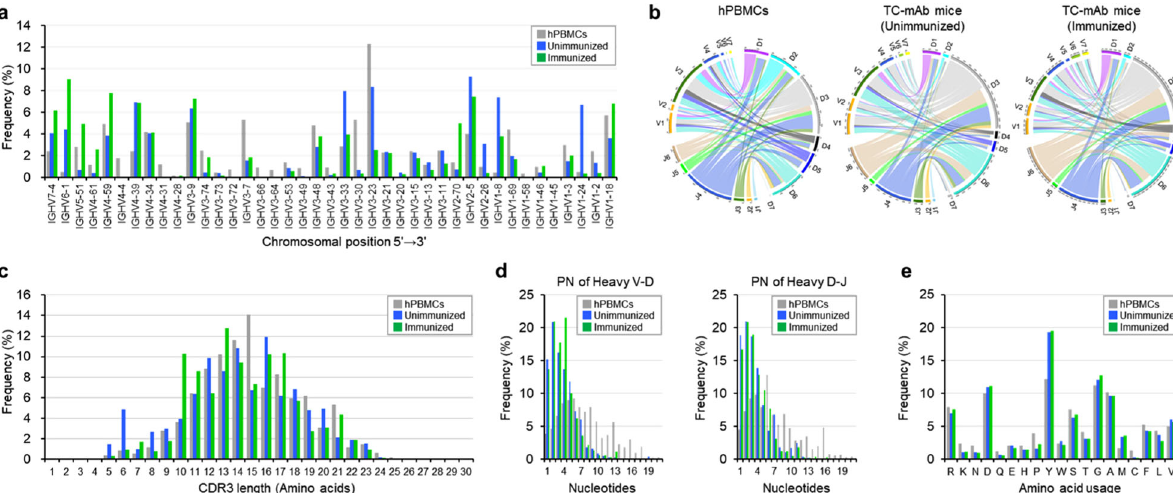
Fig. 2 Repertoire analyses of heavy chain variable regions in TC-mAb mice. a Human heavy chain gene utilization in hPBMCs from healthy donors and in TC-mAb mice with (female, 24 weeks old) and without ( fi ve female mice, 18 weeks old) immunization. Percentage frequency use of V gene segments in healthy human donors (grey), TC-mAb mice with (green) and without immunization (blue) are represented. b Circos plots comparing VDJ gene association. The gene segments are grouped as subfamilies and are shown together with the fi rst digit of their allele name. Links indicated the relative frequencies of speci fi c VDJ combinations, and wider links indicate higher frequencies of recombination. The relative CDRH3 length ( c ), P and N nucleotide addition at joining positions ( d ), and amino acid usage ( e ) within the CDRH3 of productive